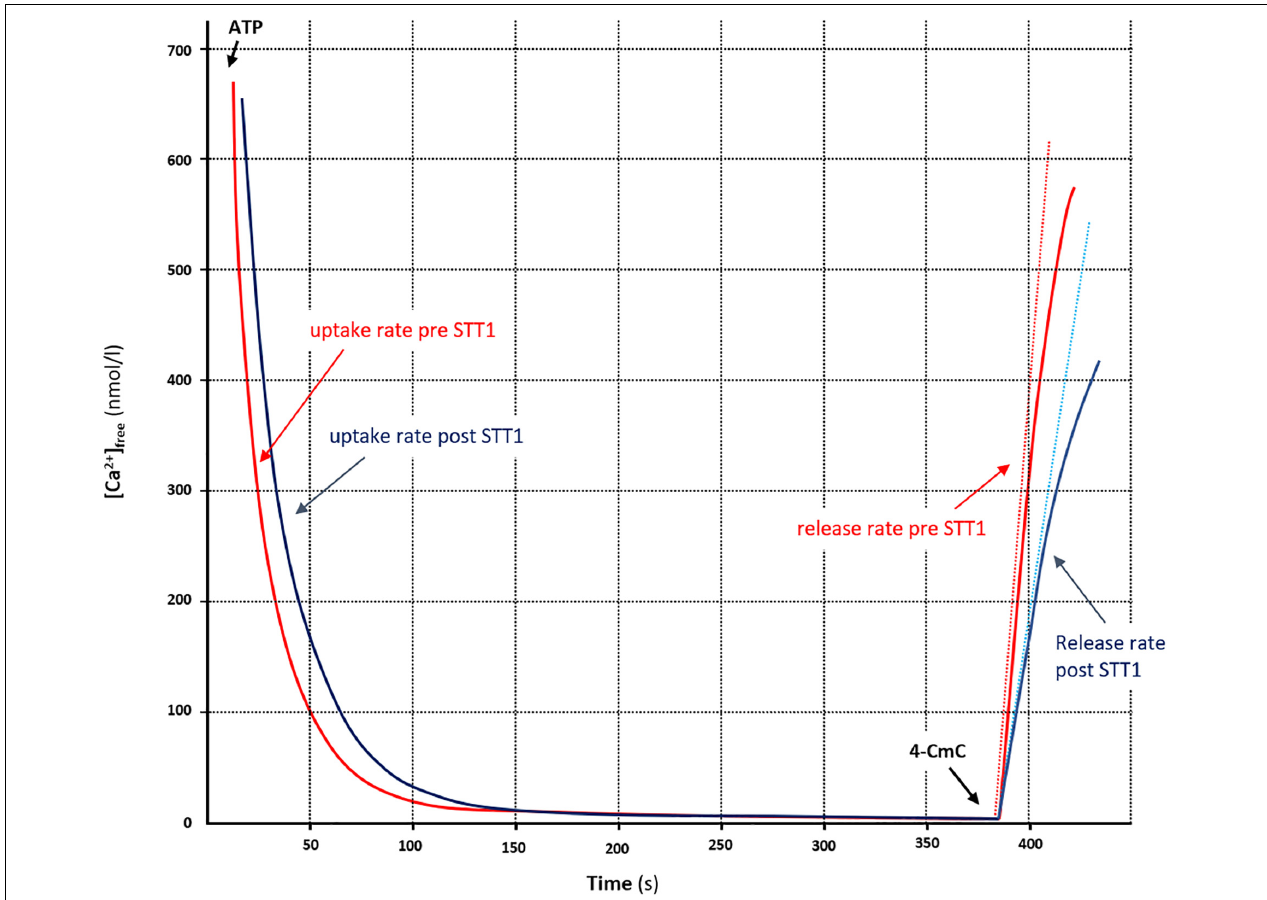
FIGURE 2 | Measurement of parameters associated with SR vesicle Ca 2 + uptake and -release from representative examples of [Ca 2 + ] traces in arm muscle, pre (STT1, red trace) and post (STT 2, blue trace) high-intensity exercise ( ∼ 4 min. in duration). The free [Ca 2 + ] was determined fluorometrically and the SR vesicle Ca 2 + uptake was initiated by adding ATP (5 mM). When [Ca 2 + ] reached a plateau, Ca 2 + release was initiated by adding 4-CmC (5 mM). Curve fitting of Ca 2 + uptake was performed with data points between a free [Ca 2 + ] of 700 nM and the free [Ca 2 + ] 20 s prior to initiating Ca 2 + release. The time ( τ ) to reach 63% of the SR vesicle uptake (i.e., the initial free [Ca 2 + ] minus nadir-Ca 2 + ) was calculated as 1/b from the equation; [Ca 2 + ] free = ae-bt +c (see section “Materials and Methods”). SR Ca 2 + release rate was obtained by mathematically fitting the data points during the first 30 s of release to the equation: y = x(1 – e-y(t-z), back-extrapolate to nadir-Ca 2 + and then the rate of Ca 2 + release was determined as the derivative of the initial release (dotted lines).